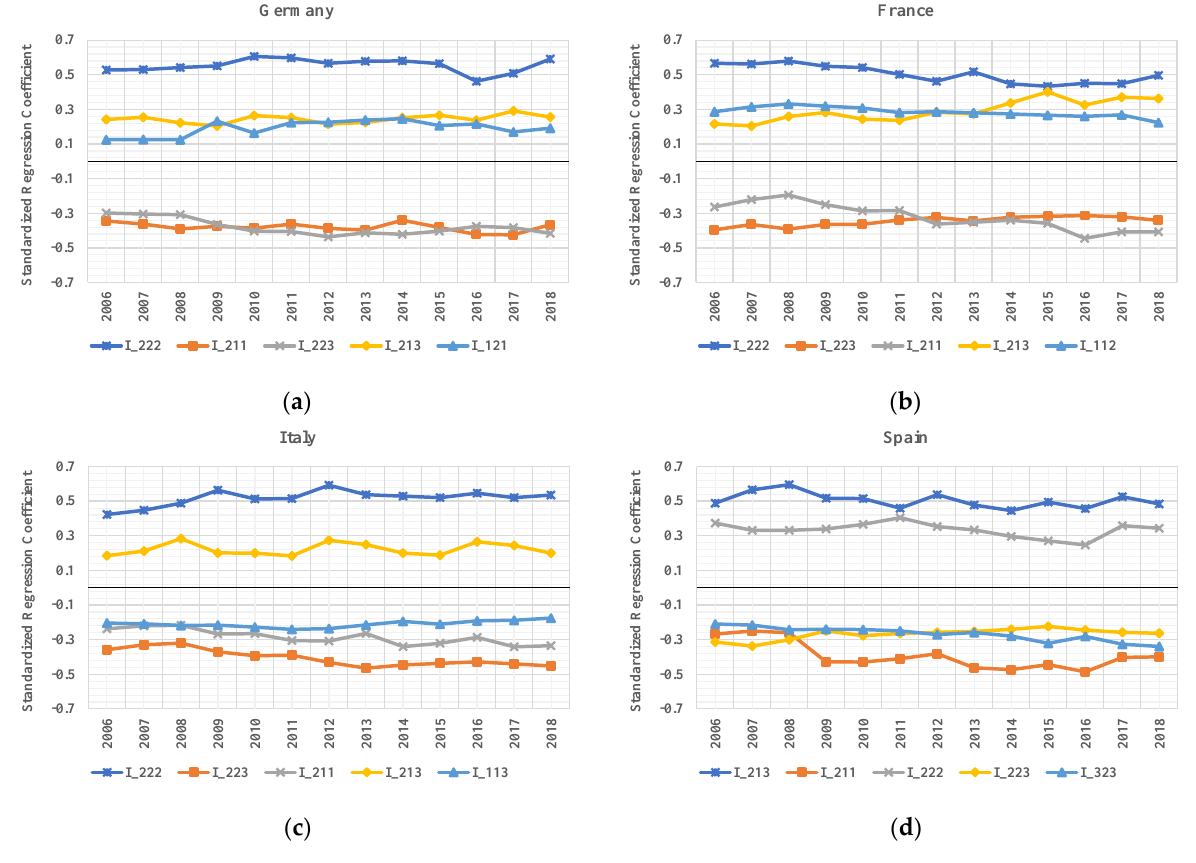
Figure 7. Results of sensitivity analysis for indicators that have the highest impact on ESL for: ( a ) Germany, ( b ) France, ( c ) Italy, and ( d ) Spain. Source: own research.